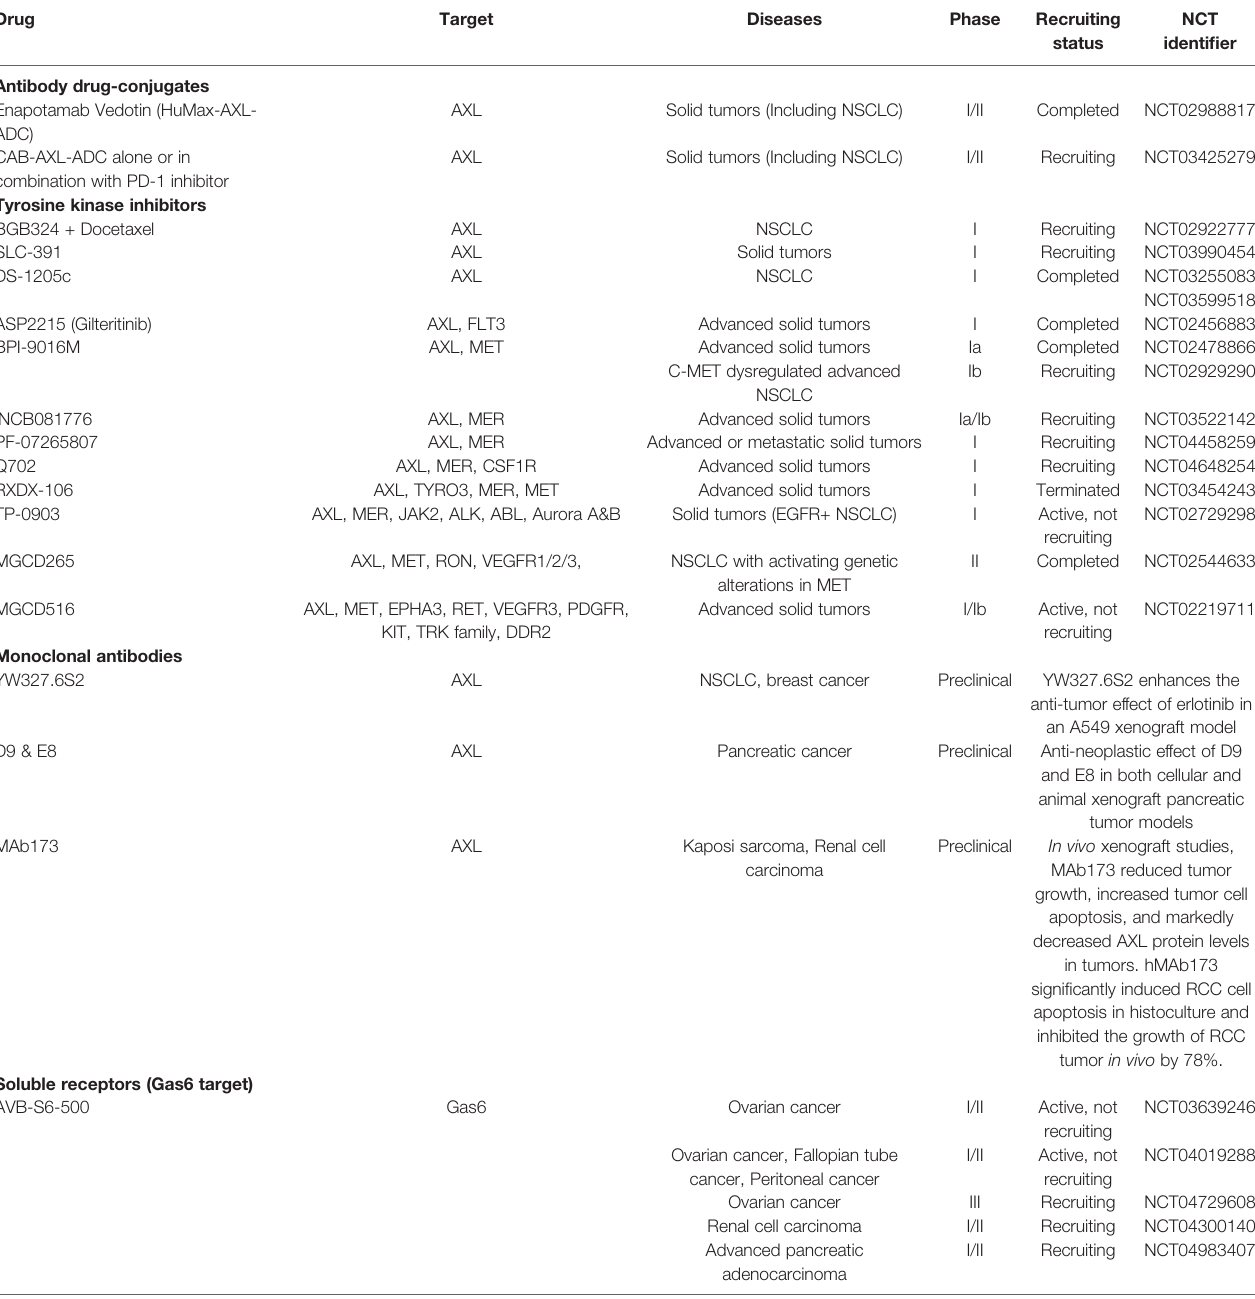
TABLE 1 | A summary of clinical trials utilizing AXL inhibitors.